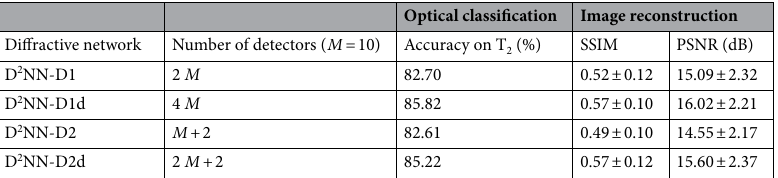
Table 2. The comparison of the presented diffractive optical networks, in terms of (1) all-optical overlapping object classification accuracies on T 2 and (2) the quality of the image reconstruction achieved through separately-trained, shallow, electronic networks (decoder). The mean SSIM and PSNR values and their standard deviations were computed over the entire 10 K blind test inputs (T 2